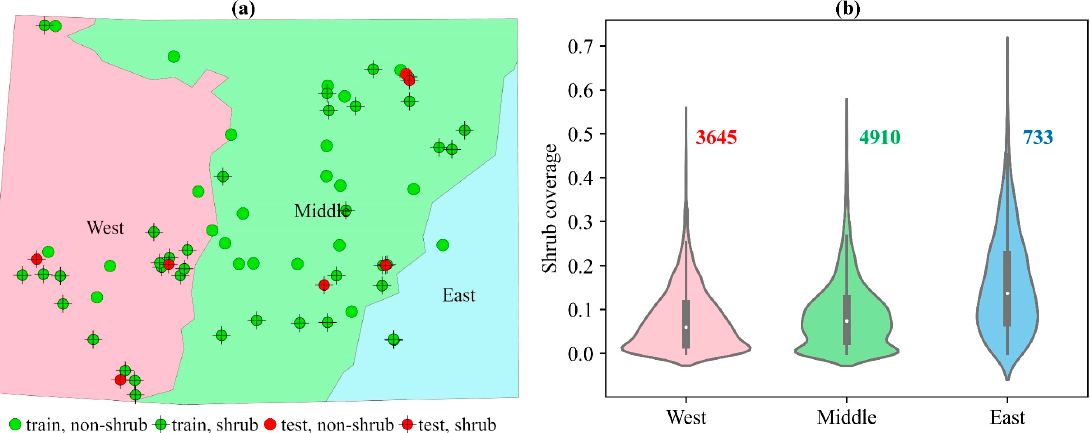
Figure 4. The zoning results of the study area ( a ) and the violin histogram of shrub coverage for sample pixels in each subregion ( b ). The locations of training samples (green dots) and test samples (red dots) in each subregion are shown in ( a ). The number on ( b ) represents the total number of pixels in each subregion.